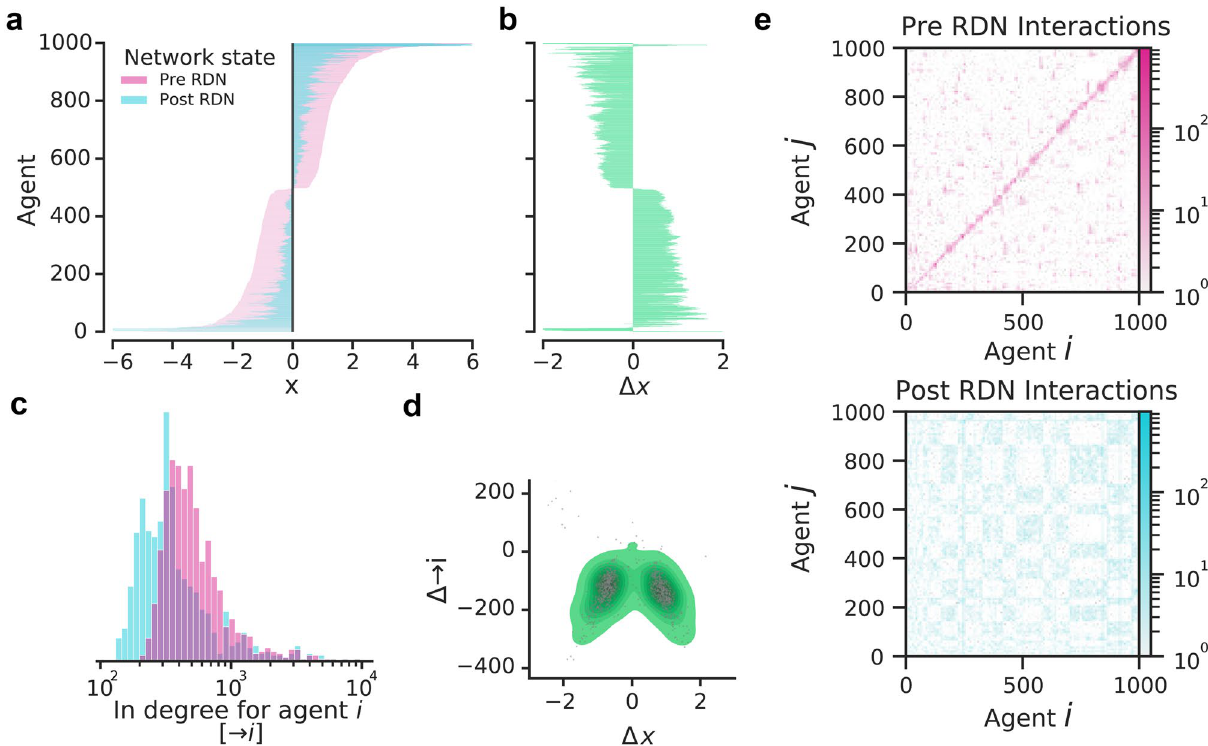
Figure 4. The effect of the RDN on an agent’s opinion and interactions in the network. From a simulation in 3 ), each agent i ’s opinion x is shown at t 10 (“Pre RDN”, pink) and at t 20 (“Post RDN”, light Fig. 3 ( D = = = blue) (a), as well as their change in opinion, (cid:31) x , ( b ). The incoming interactions from other agents to an agent i ) is shown in ( c ) as a probability histogram P ( i i ) . The density of in degree change (cid:31) i (“in degree”, → → → as a function of (cid:31) x ( d ). The interactions between agents before the RDN (e, top panel) show a large number of interactions and small groups. That is in contrast to after the RDN ( e , bottom panel), which shows fewer interactions but larger groups. Note that activity probabilities a i remained the same throughout the simulation. 10 , K 3 , α 3 , β 30 , and r 0.5 . 3 , n Other parameters were m = = = = = =